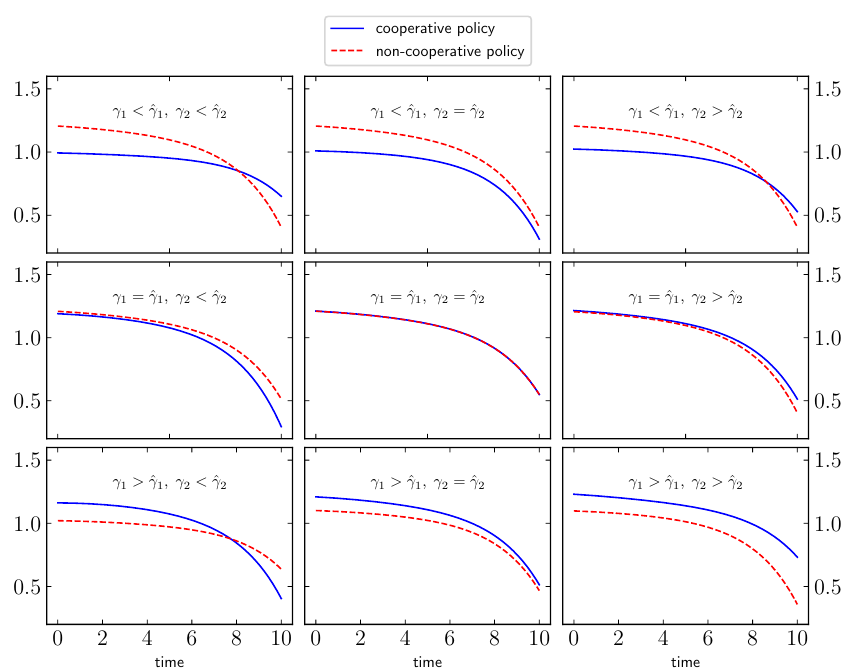
Figure 5. Comparison of the aggregated running cost in the cooperative regime (blue line) and the sum of the two running costs in the non-cooperative regime (red dashed line) starting at “ 0.5, x 0 “ 0.2). Pollution control and fish population control after T “ 10 months are u ( x 0 2 1 p T q “ 0.9, respectively, and α and u 2